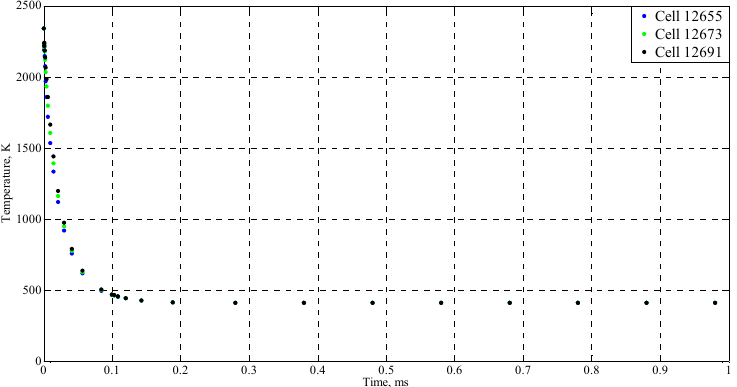
Figure 11. Temperature evolution in the splat cells 12655, 12673 and 12691.